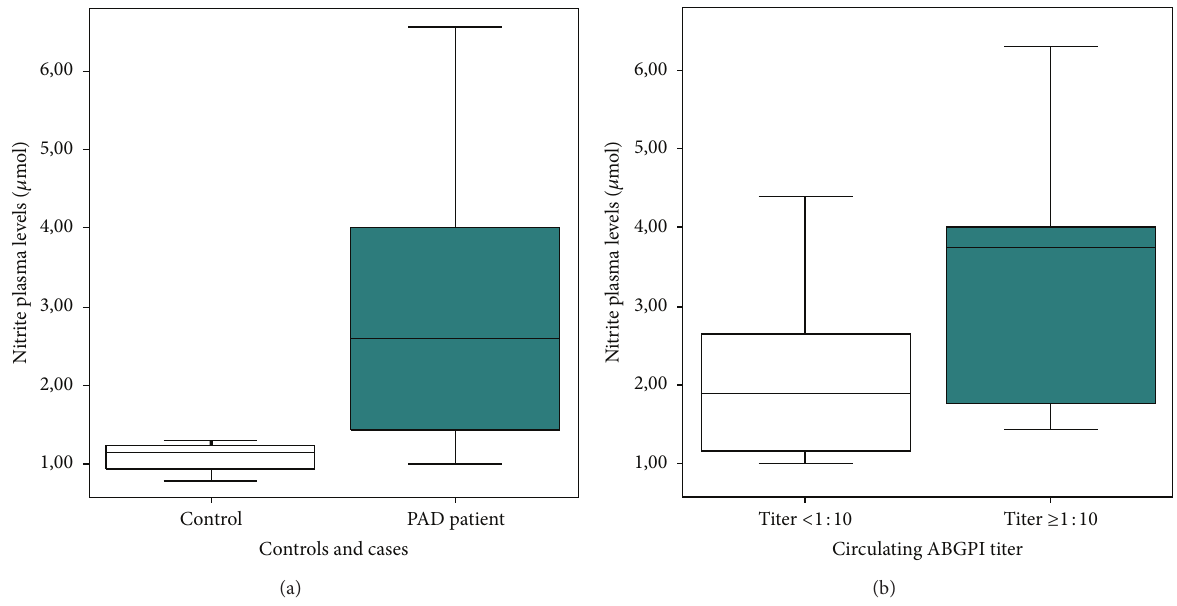
Figure 4: Nitrite plasma levels. (a) Peripheral arterial disease patients showed nitrite plasma levels ( 𝑃 < 0.01 ). (b) Nitrite plasma levels were higher in patients with circulating anti-beta2-glycoprotein antibodies (ABGPI) titer ≥ 1:10 ( 𝑃 < 0.01